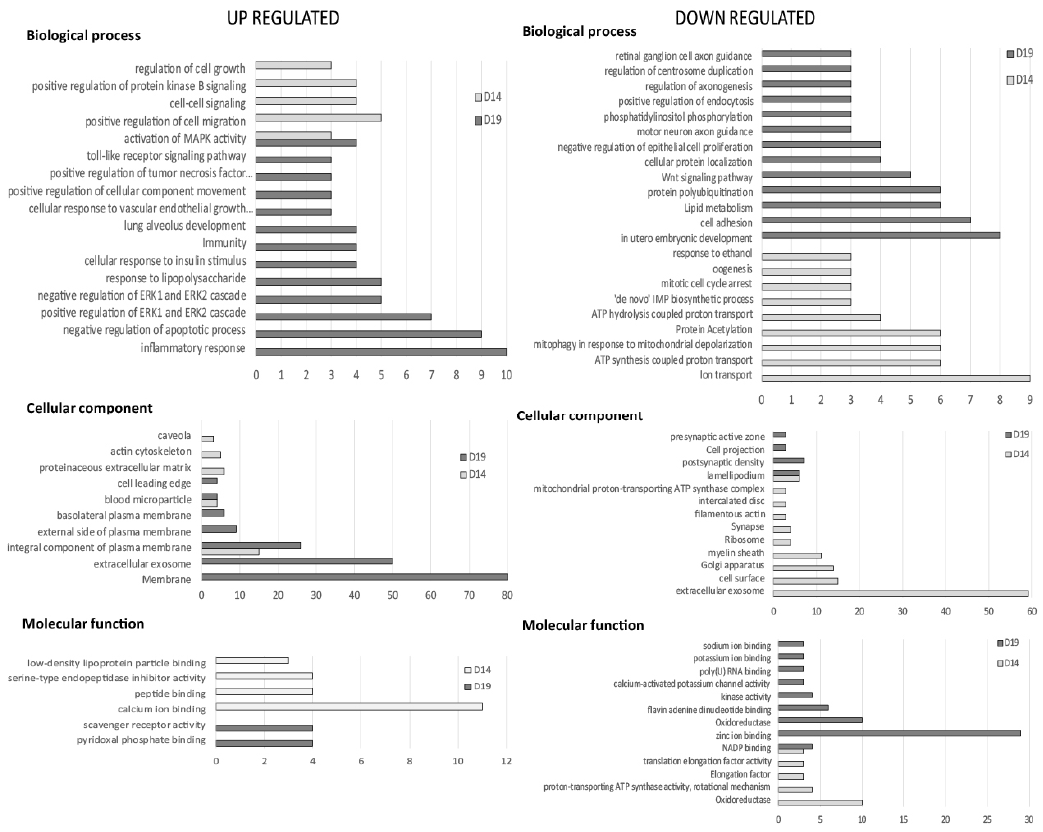
Figure 5. Gene ontology analysis for genes upregulated and downregulated in equine endometrium on day 14 and 19 of pregnancy between synchronous (recipient and donor ovulated on same day) and asynchronous (recipient ovulated 5 days after the donor) embryo transfer (ET; D14 syn / asyn and D19 syn / asyn). The major categories within the biological process, cellular component and molecular function are represented by the number of genes in the category, selected on the basis of a p -value < 0.05.